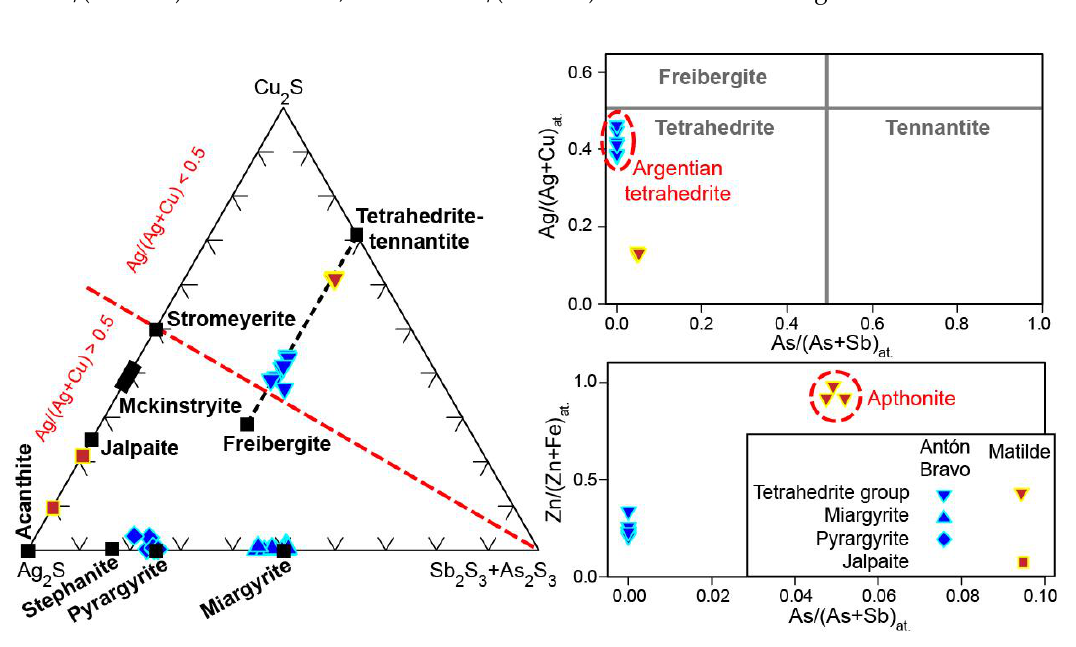
Figure 13. Plot of the analyzed tetrahedrite group minerals and Ag–Cu–Sb sulfosalts from the Huari Huari district in the Ag 2 S vs. Cu 2 S vs. Sb 2 S 3 + As 2 S 3 ternary diagram (left) and of the tetrahedrite group minerals in the As/(As + Sb) vs. Ag/(Ag + Cu) and Zn/(Zn + Fe) binary diagrams (right).